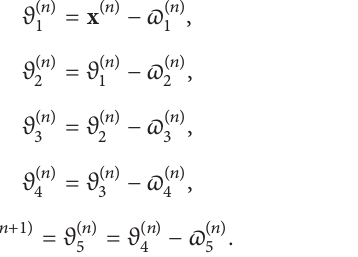
(𝑛) wherein 𝜗 𝑖 is used in the linear system